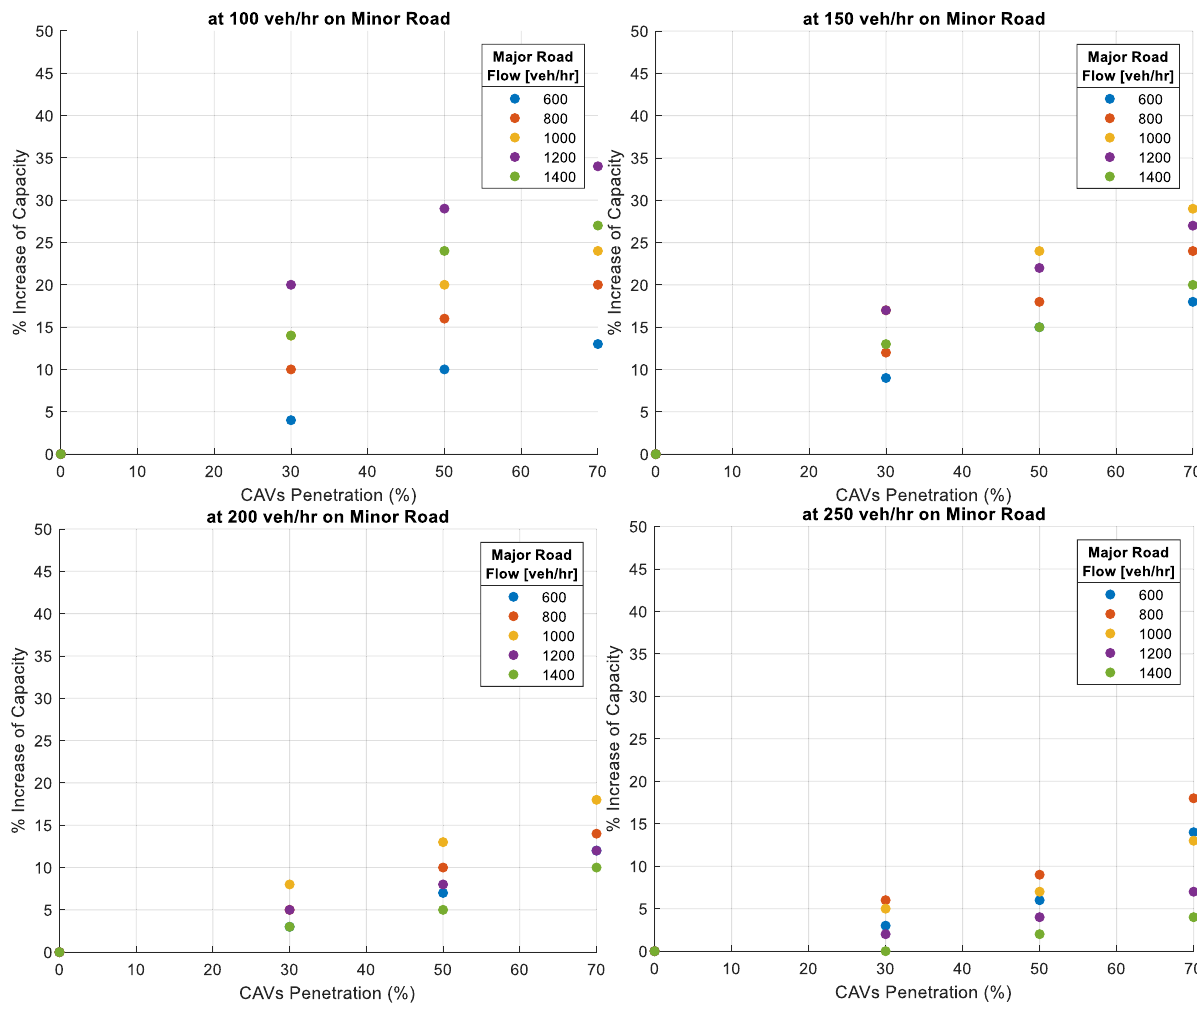
Figure 15: Surplus capacity at di ff erent levels of tra ffi c volume.